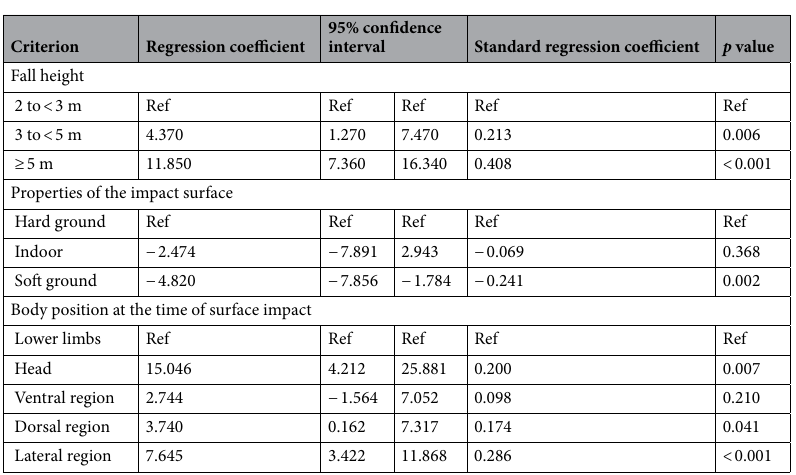
Table 3. Multiple regression analysis results for the injury severity